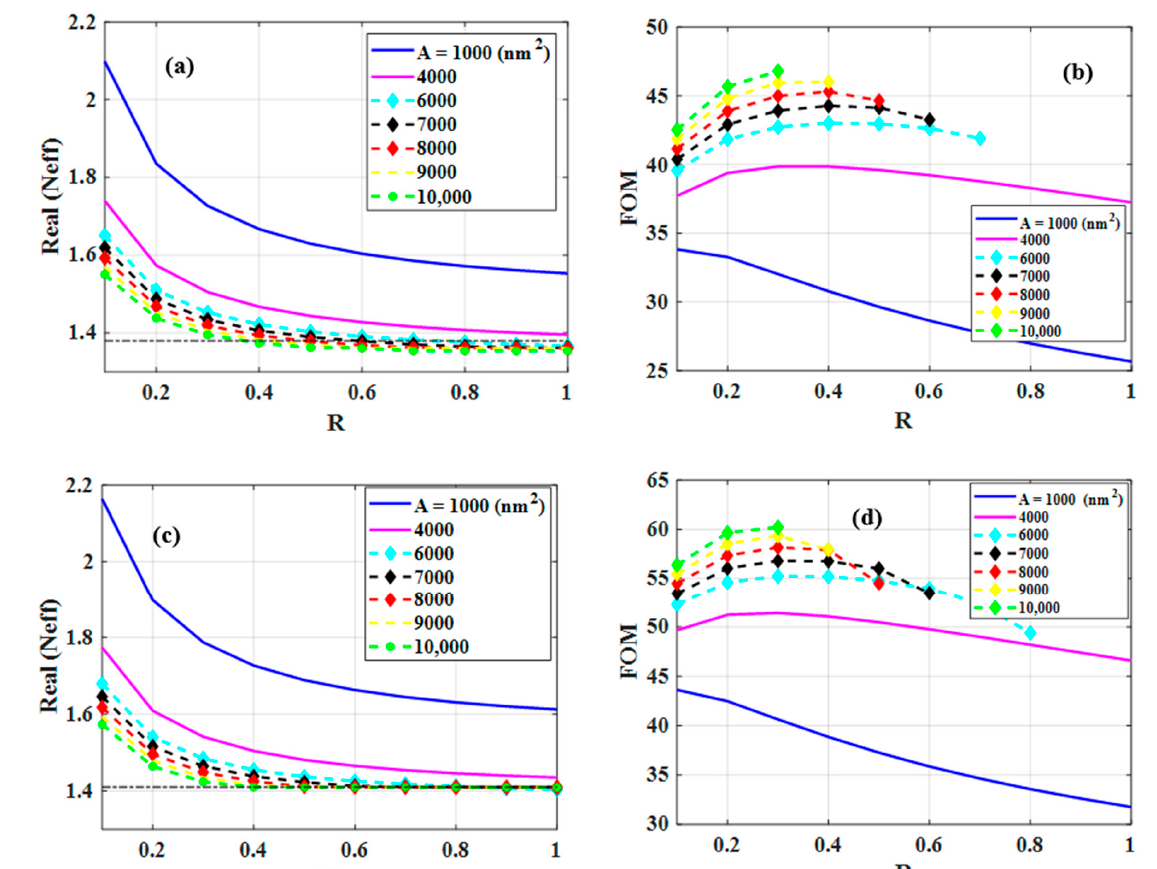
Figure 10. The real part of the effective mode index ( N ef f ) of the plasmonic slot waveguide (PSWG) as a function of ratio between slot width and height (R) for different values of slot area ( A ) for a wavelength of ( a ) 4.26 µm and ( c ) 3.1 µm. The horizontal dashed line represents the refractive index of the silica substrate. The FOM of the fundamental guided mode of the PSWG versus R for different A for a wavelength of ( b ) 4.26 µm and ( d ) 3.1 µm.